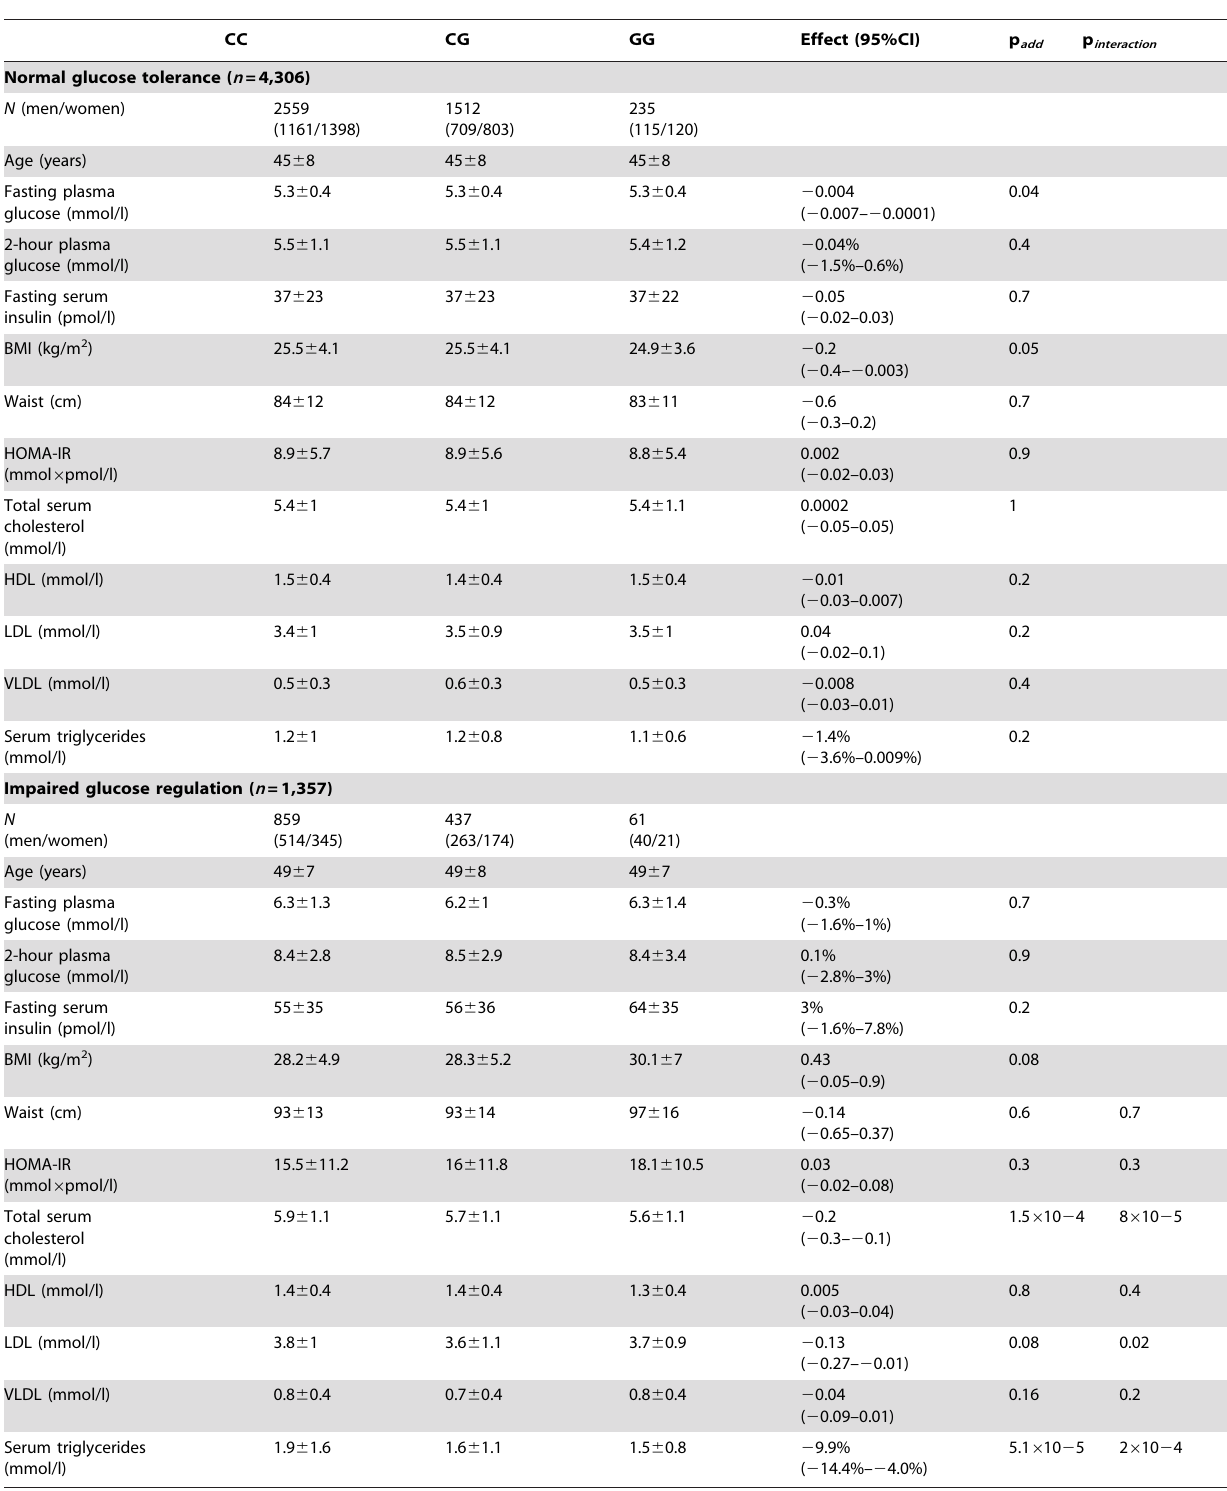
Table 2. Quantitative traits among individuals from the Inter99 cohort according to PNPLA3 rs738409 genotype.